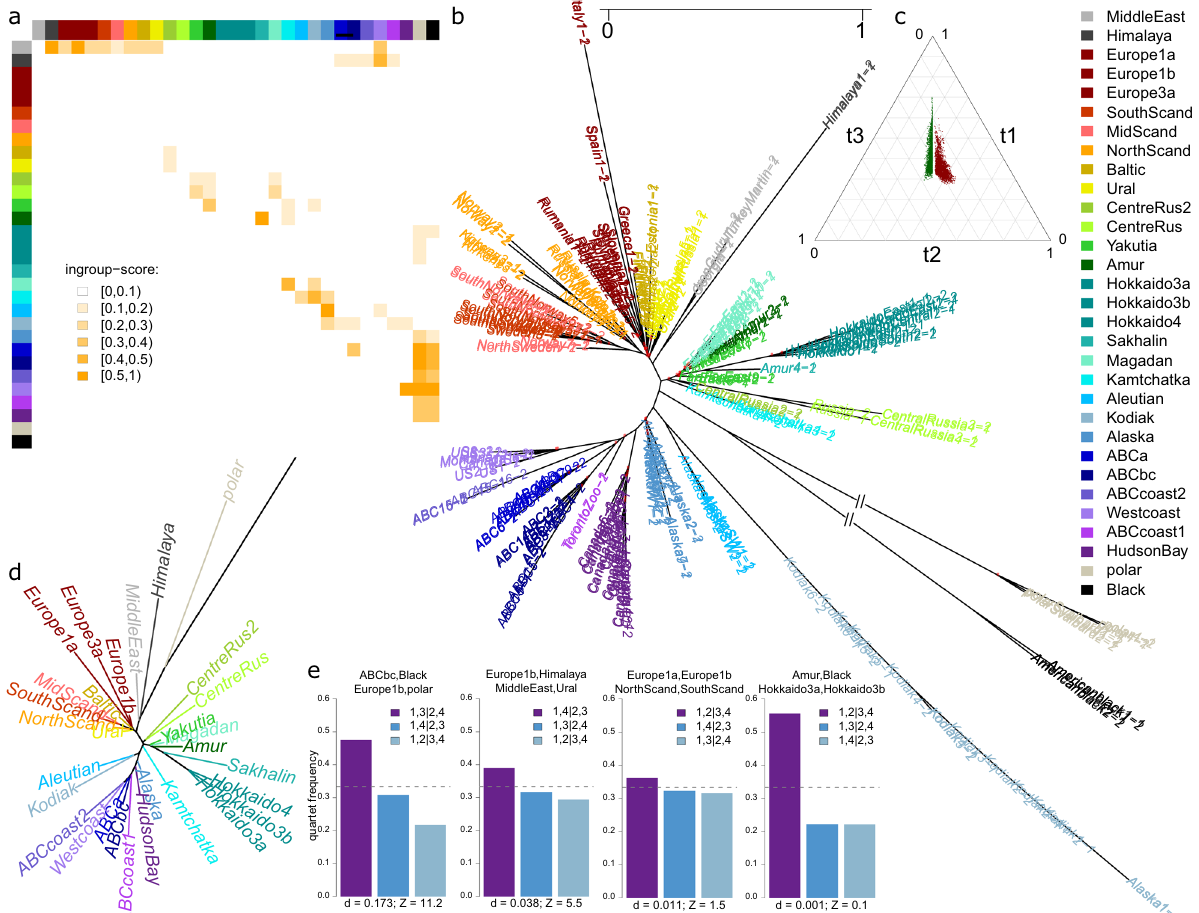
Fig. 5 Multispecies coalescent (MSC) based analyses: testing for inequality of alternative quartet topology frequencies. Graphical summary of MSC- based analyses on 3075 haploblocks of at minimum 25kb length. Haploblocks were detected using Plink, and each haploblock dataset was phased with Beagle, generating two haplotypesper individual (which were randomly marked − 1 and − 2). Quartet frequencies were calculatedandaggregatedperpopulation quartet using thesoftwareTwisst.Thepopulations ofEuropeandHokkaido weresubdivided accordingtomtDNAclusters.Quartetfrequencieswerede fi nedast1,t2and t3, referring respectively to the species tree topology q1, the most frequent alternative topology q2, and the less frequent alternative topology q3. a